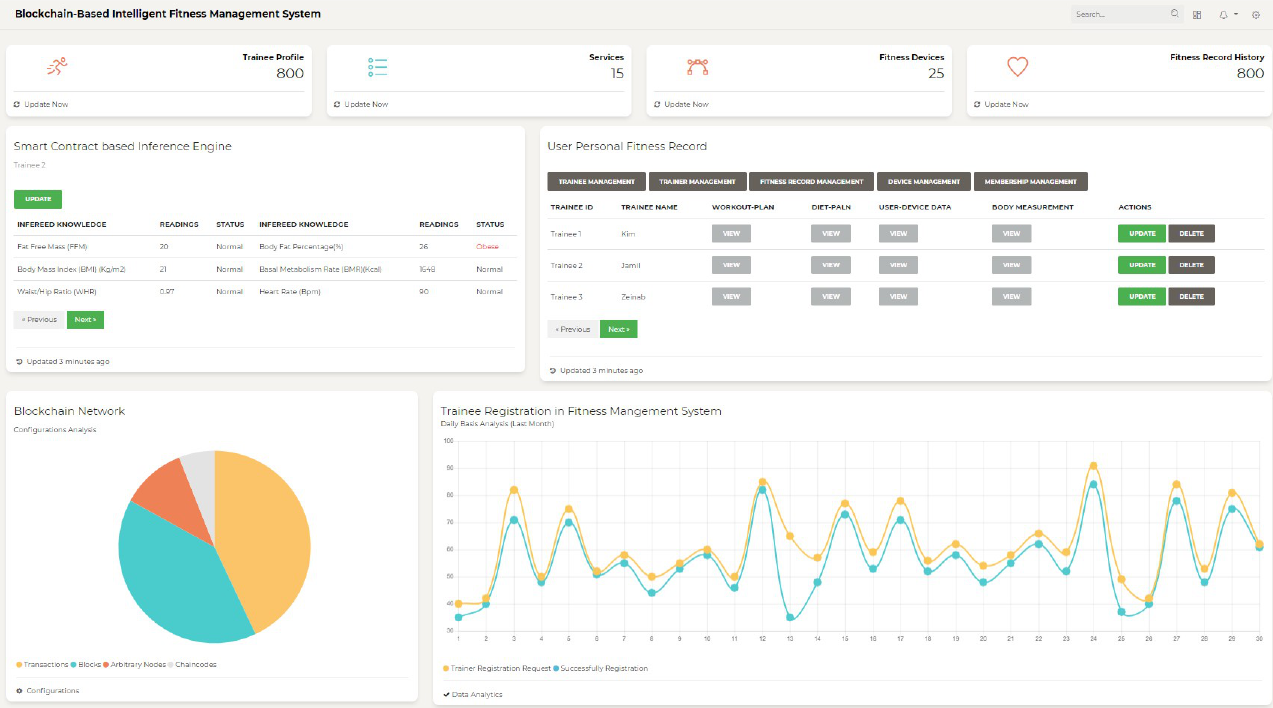
Figure 11. Intelligent fitness service front-end user